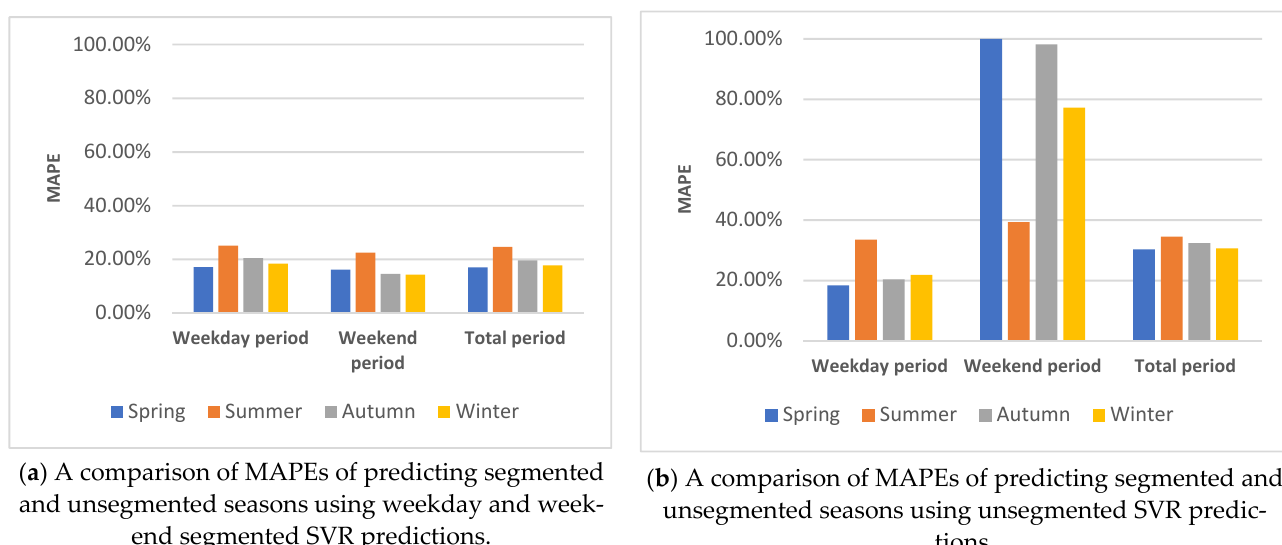
( b ) A comparison of MAPEs of predicting segmented and unsegmented seasons using unsegmented SVR predic- tions. Figure 17. A comparison of weekday and weekend segmented and unsegmented SVR predictions’